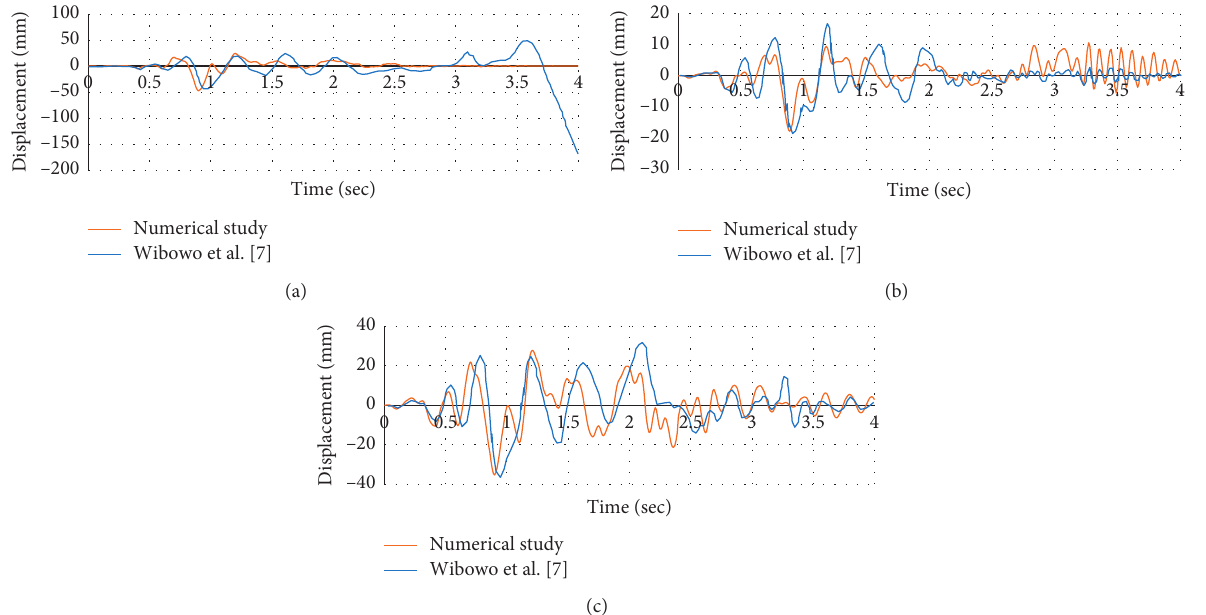
Figure 9: Comparison between the displacement time history of the top end of the piers of the numerical study and the research of Wibowo et al. [7] (nonlinear box girder). (a) Short pier. (b) Medium pier. (c) Tall pier.